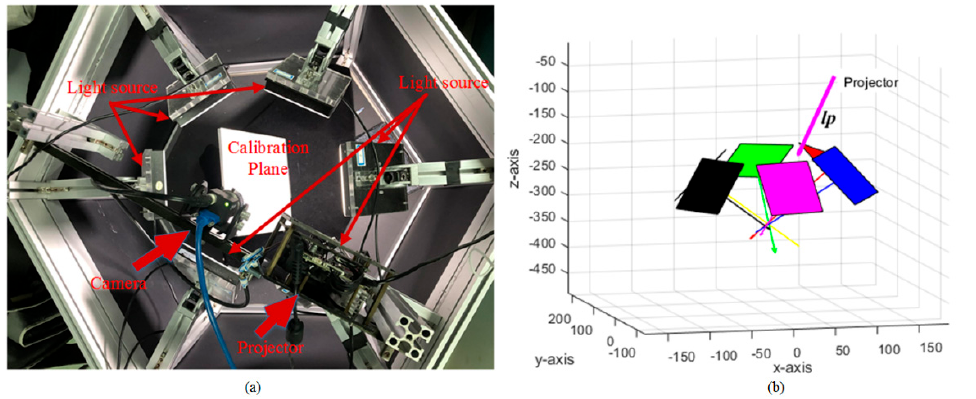
Figure 7. Hardware and calibration results. ( a ) Our hardware consists of a camera, a projector and six area light sources; ( b ) The illustration of calibration results; the length and direction of arrow represents the intensity and direction of light source.